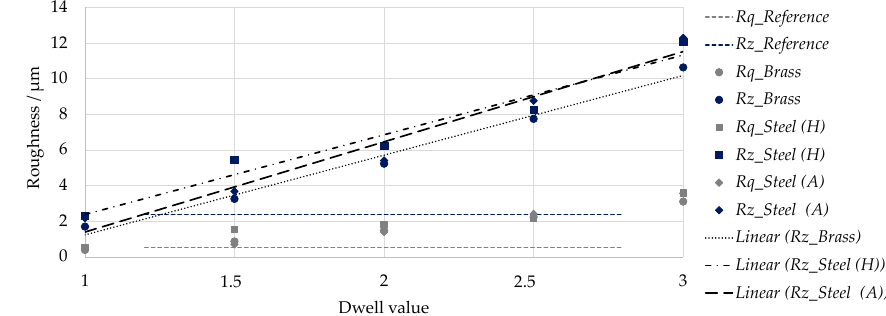
Figure 11. Results of the roughness measurement.